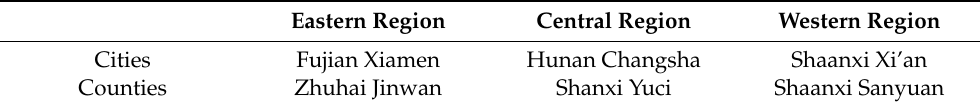
Table 1. Surveyed Cities. Eastern Region